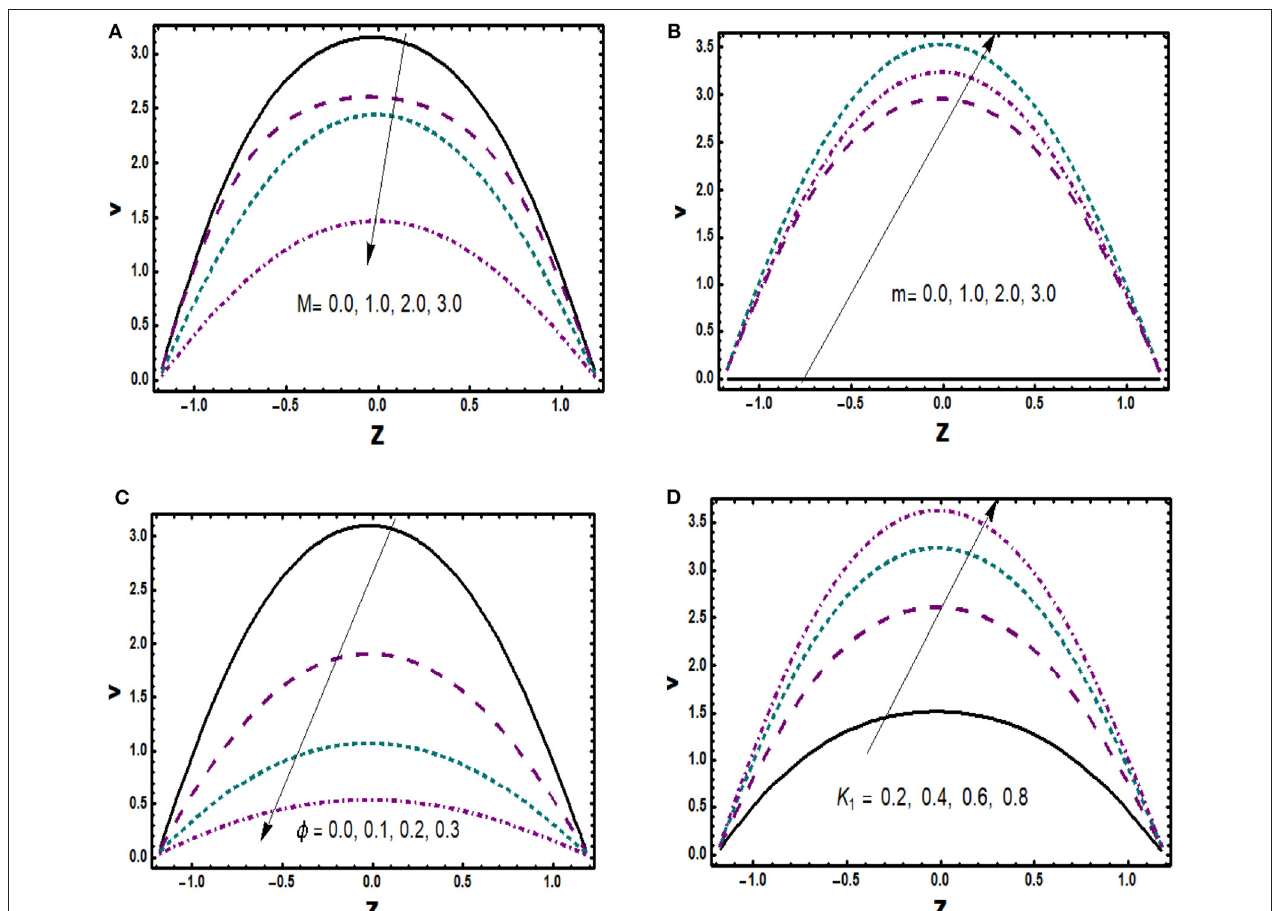
FIGURE 5 | (A–D) Effects of M , m , φ , and K 1 on v ( z ).